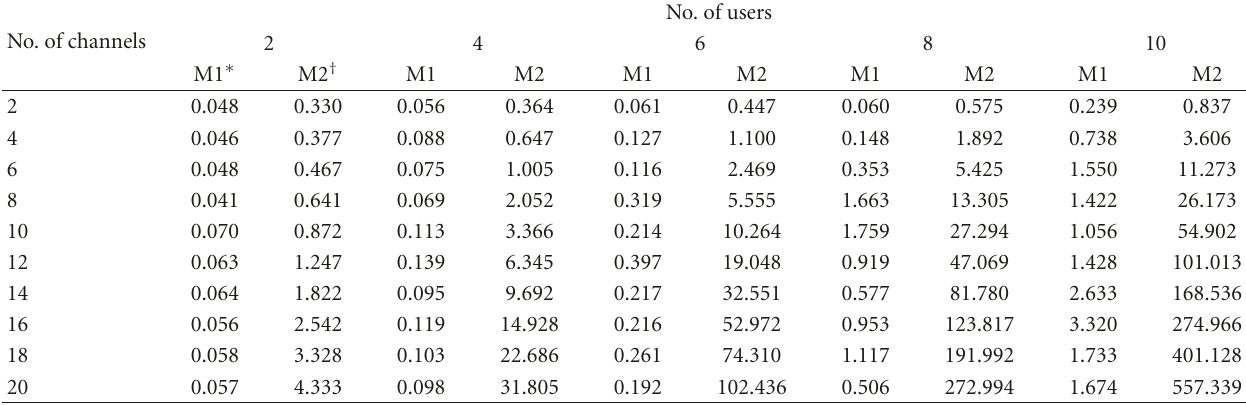
∗ M1: iterative algorithm † M2: solving entire optimal conditions.